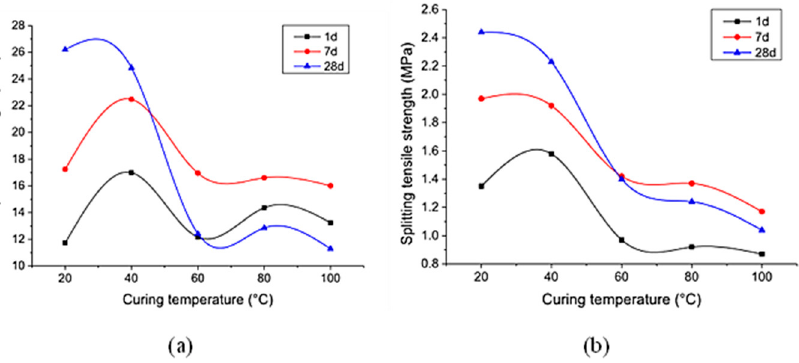
Figure 6. Mechanical properties of specimens under various working conditions: ( a ) compressive strength test, ( b ) splitting tensile strength test [50].